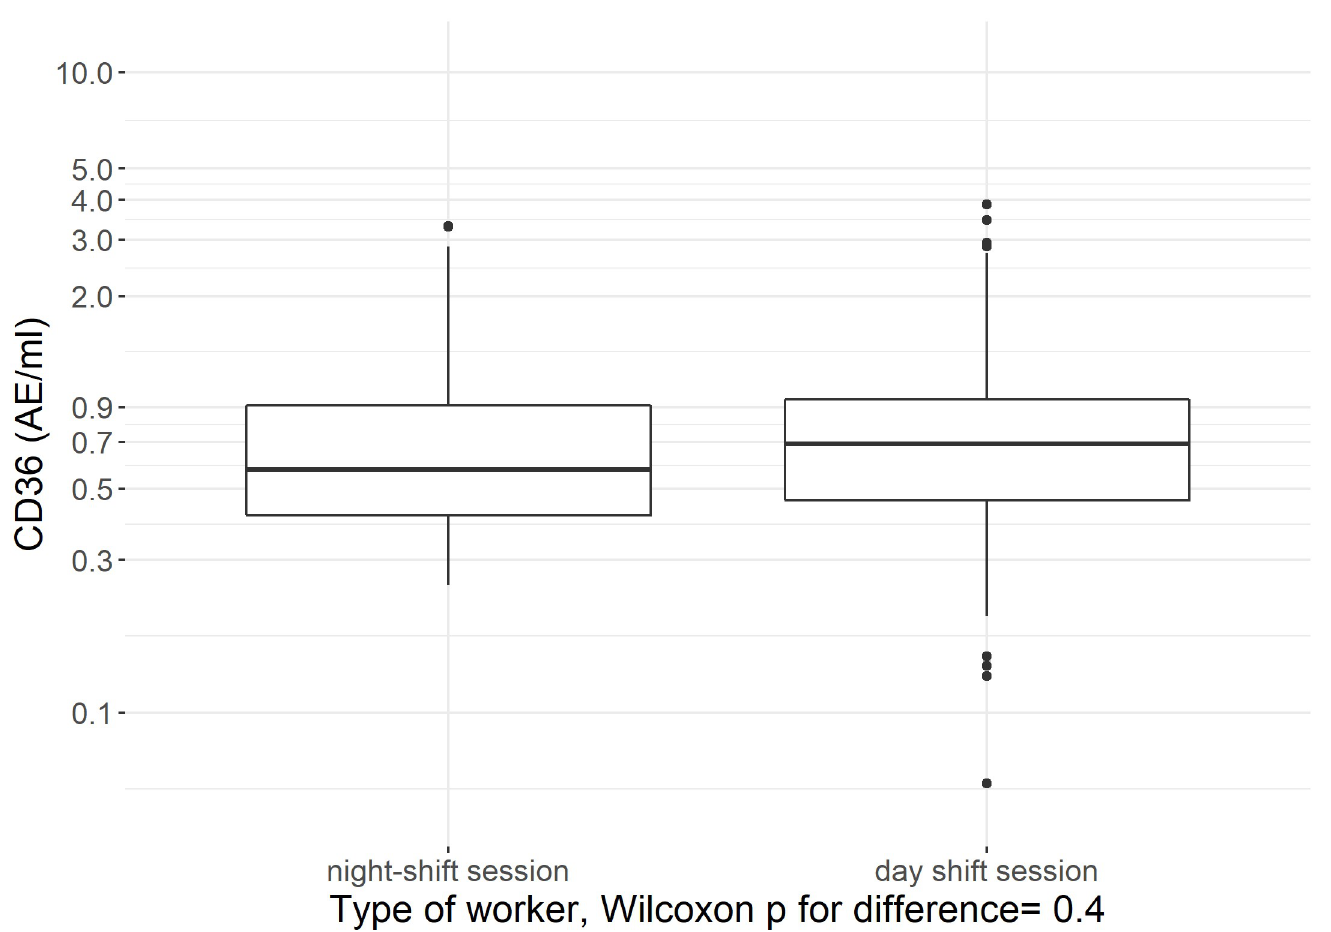
Fig 3. Log-transformed sCD36 levels in samples collected during night-shift sessions and day-shift sessions among night-shift workers.